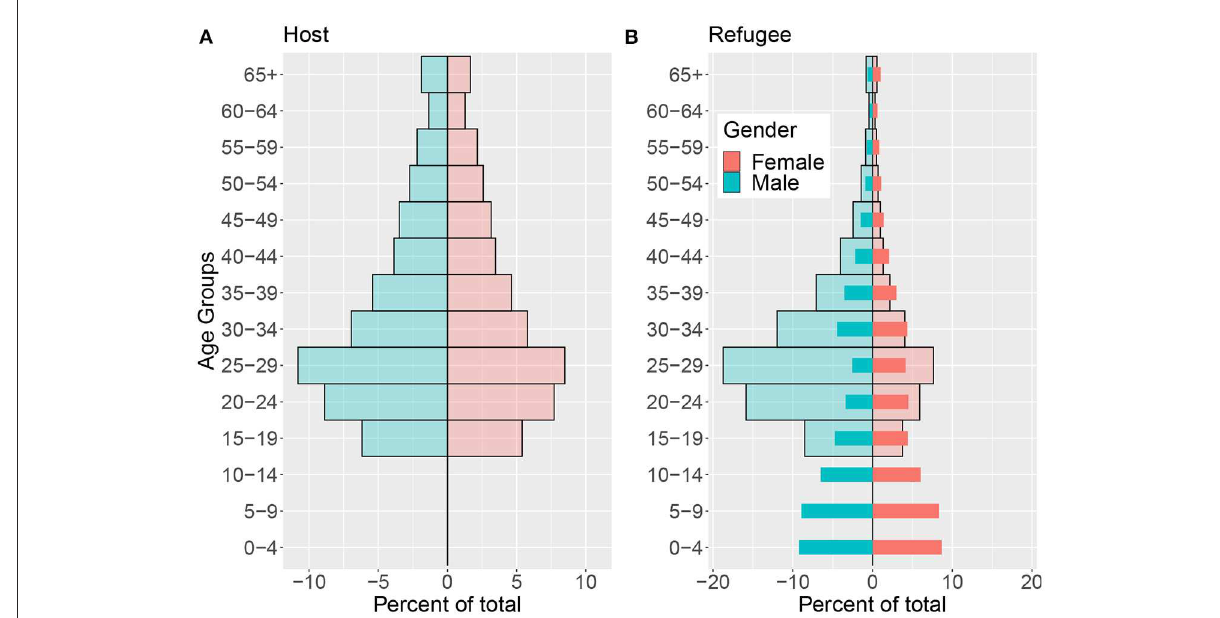
FIGURE6 Population pyramids. (A) Shows the population distribution by age and gender of Facebook users aged 13+ for the host community. (B) Shows the age and gender distribution of Facebook users 13+ for the refugee community (translucent bars) overlaid with the refugee population pyramid from survey data (thin, solid